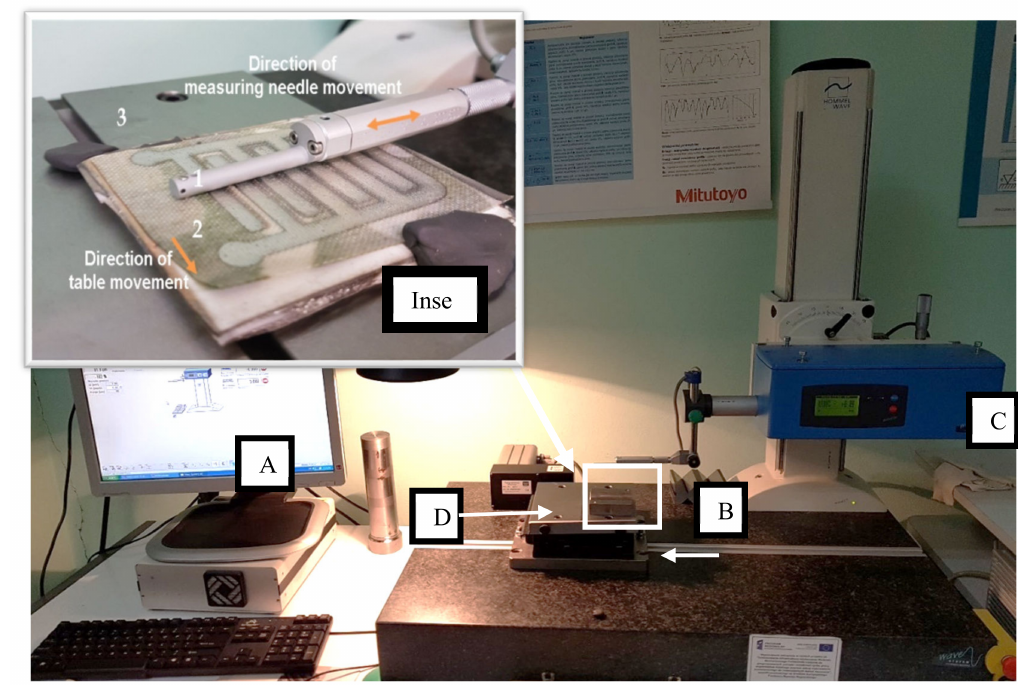
Figure 3. Measuring stand for contact surface topography measurement: A —computer with software; B —measured sample; C —TurboWaveline60 profilograph; D —sliding table. Inset: method and directions of measuring the topography of the surface layer of the tested material: 1 —measuring needle; 2 —sample; 3 —moving table.